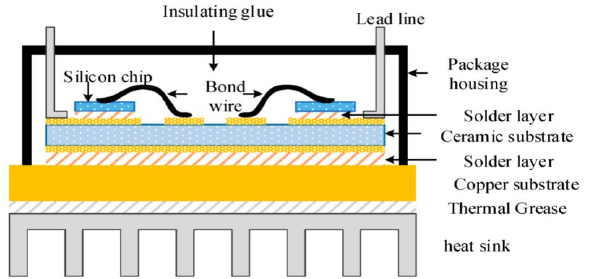
Figure 17. Geometric description and physical structure of the IGBT module [20].